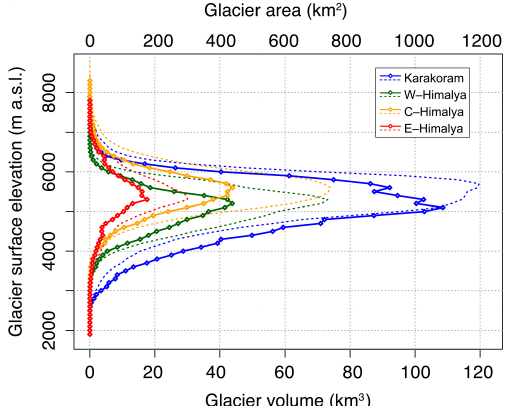
Figure 7. Hypsometric distribution of area (dashed lines, top x axis) and volume (solid lines, bottom x axis) for the four sub-regions as calculated with GlabTop2. Elevation values refer to the glacier sur- face elevation. Note the different scale of the two x axes, intersec- tions of the two lines correspond to a mean ice thickness of